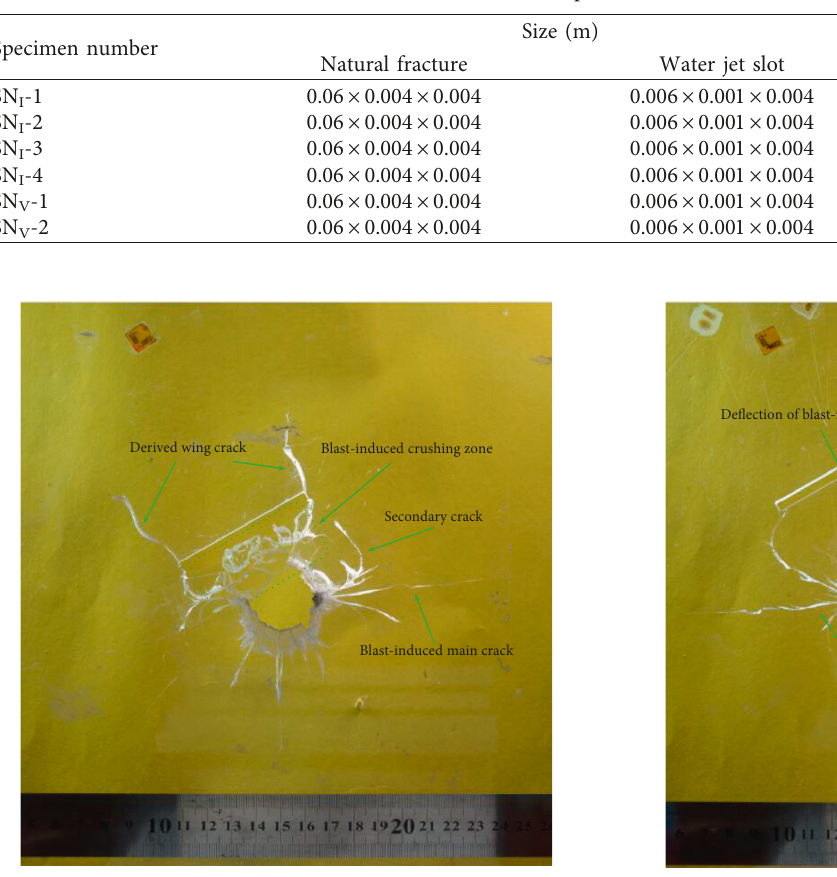
Figure 22: Blasting effect drawing for case SN I -1.